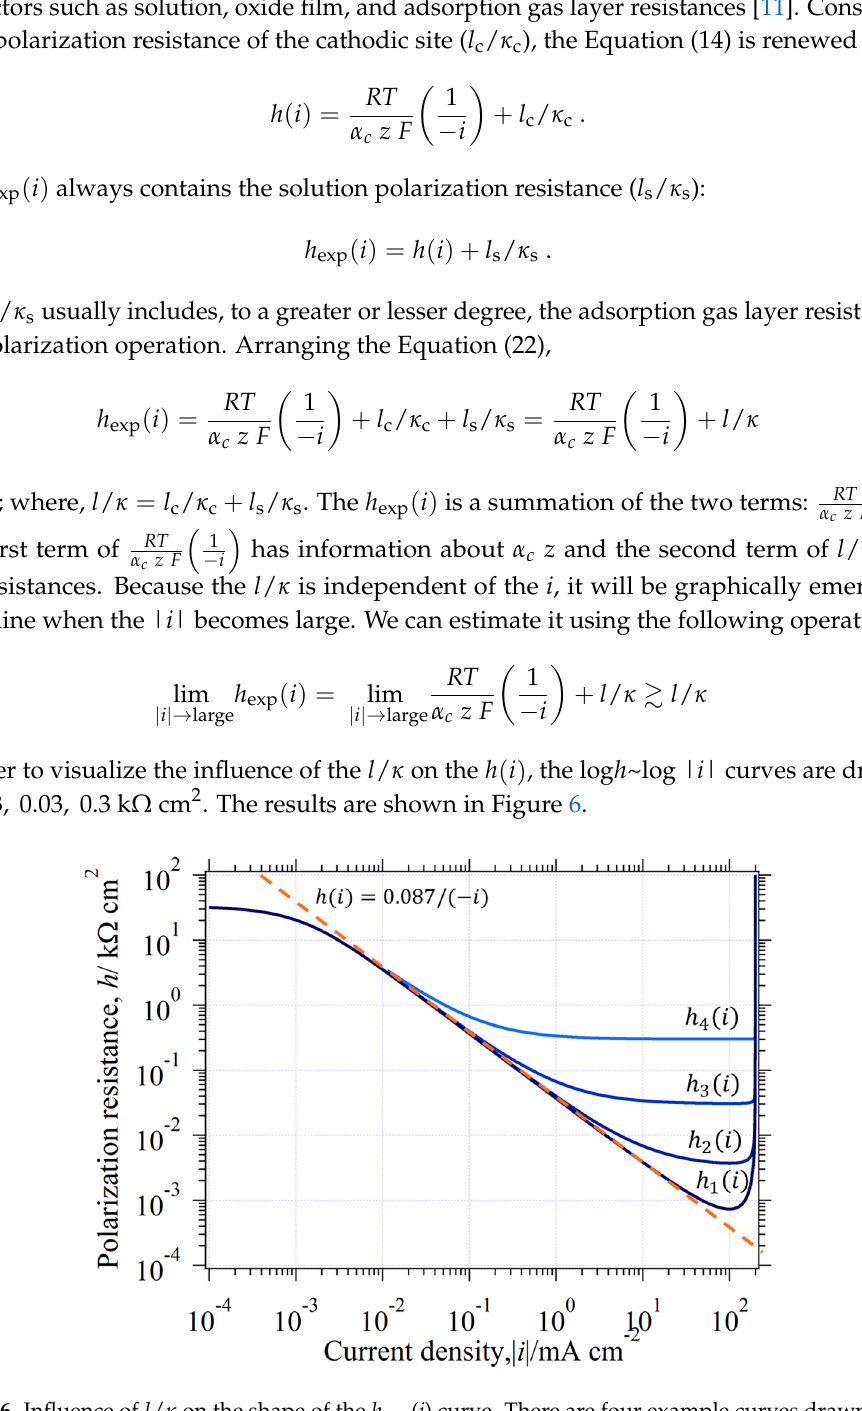
Figure 6. Influence of (cid:1864)/(cid:2018) on the shape of the h exp ( i ) curve. There are four example curves drawn Figure 6. Influence of l / κ on the shape of the h exp ( i ) curve. There are four example curves drawn using using the same data in Table 1: (cid:1860) (cid:2869) (cid:4666)(cid:1861)(cid:4667) (cid:3404) (cid:1860) ∗ (cid:4666)(cid:1861)(cid:4667) (cid:3397) 0 kΩ cm (cid:2870) (as a blank test), (cid:1860) (cid:2870) (cid:4666)(cid:1861)(cid:4667) (cid:3404) (cid:1860) ∗ (cid:4666)(cid:1861)(cid:4667) (cid:3397) the same data in Table 1: h 1 ( i ) = h ∗ ( i ) + 0 k Ω cm 2 (as a blank test), h 2 ( i ) = h ∗ ( i ) + 0.003 k Ω cm 2 , h 3 ( i ) = h ∗ ( i ) + 0.03 k Ω cm 2 , h 4 ( i ) = h ∗ ( i ) + 0.3 k Ω cm 2 , where h ∗ ( i ) = 0.087 An orange broken line of h ( i ) = 0.087/ ( − i ) , on which the Tafel relation is completely satisfied, is added as a